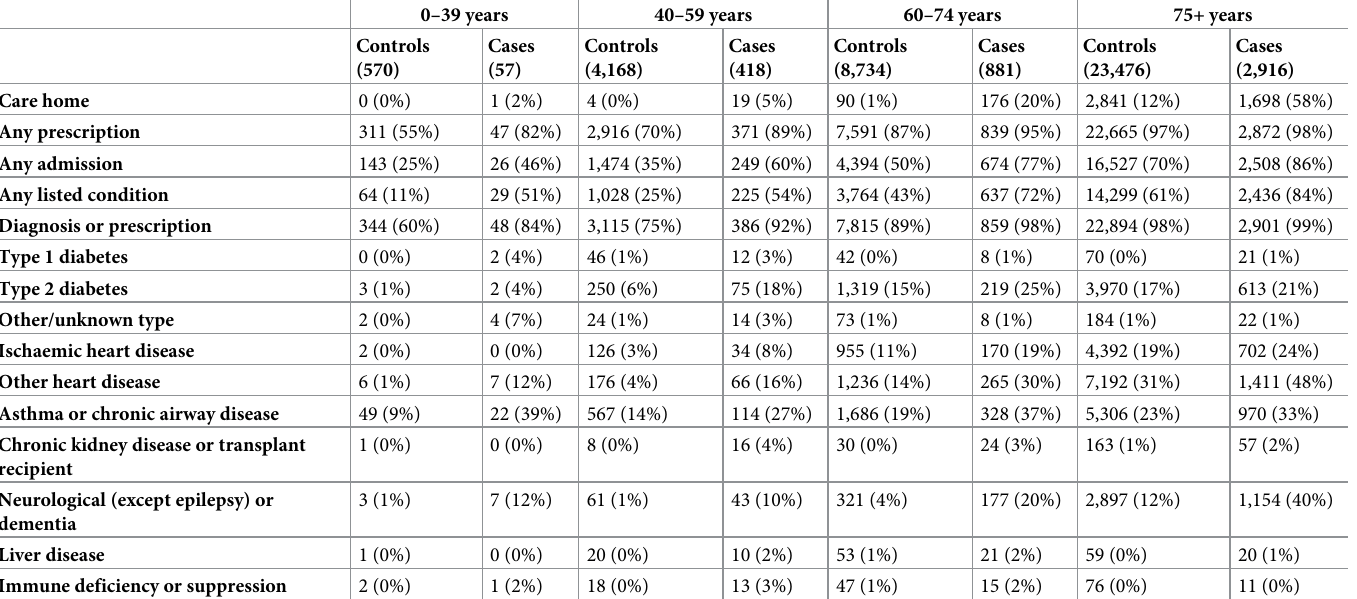
Table 2. Frequencies of risk factors in cases and controls, by age group.